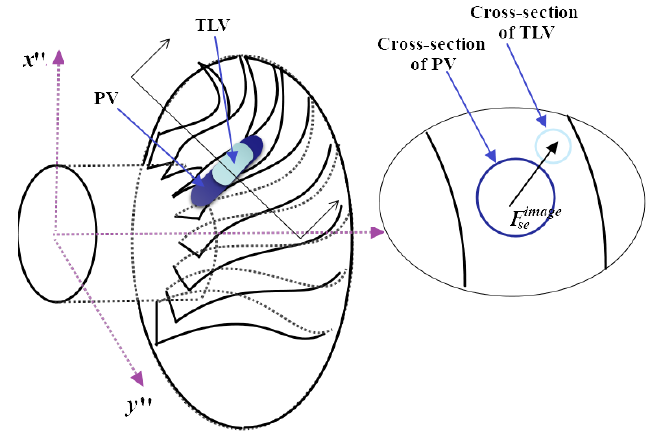
Figure 8. Schematic of the passage vortex squeeze effect.